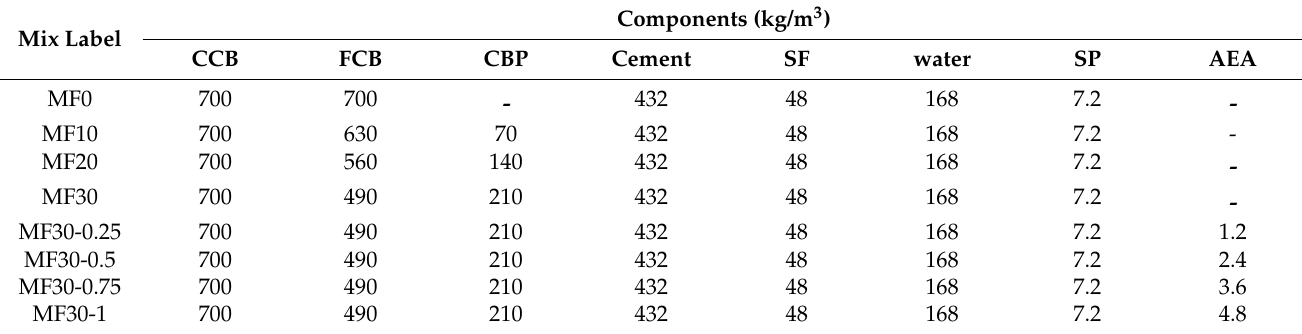
Table 3. Mixture proportions of the concrete (kg/m 3 ).